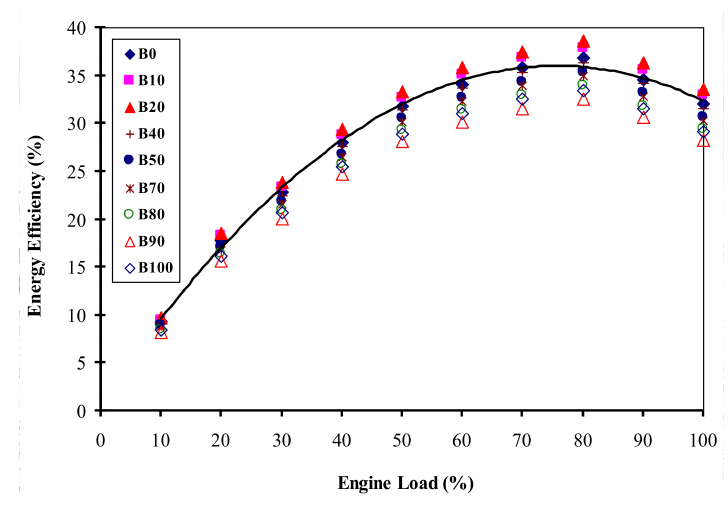
Figure 5. Energy efficiency of the engine.